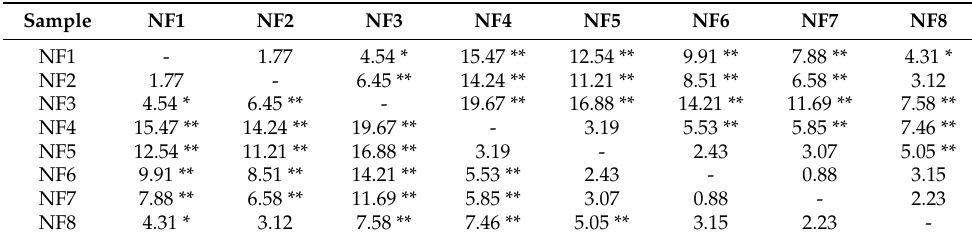
Table 4. Q statistic values of the different nanofibrous formulations as pairs of treatments in one-way ANOVA with post hoc Tukey HSD test. The significantly different (** p < 0.01; * p < 0.05) pairs of treatments are